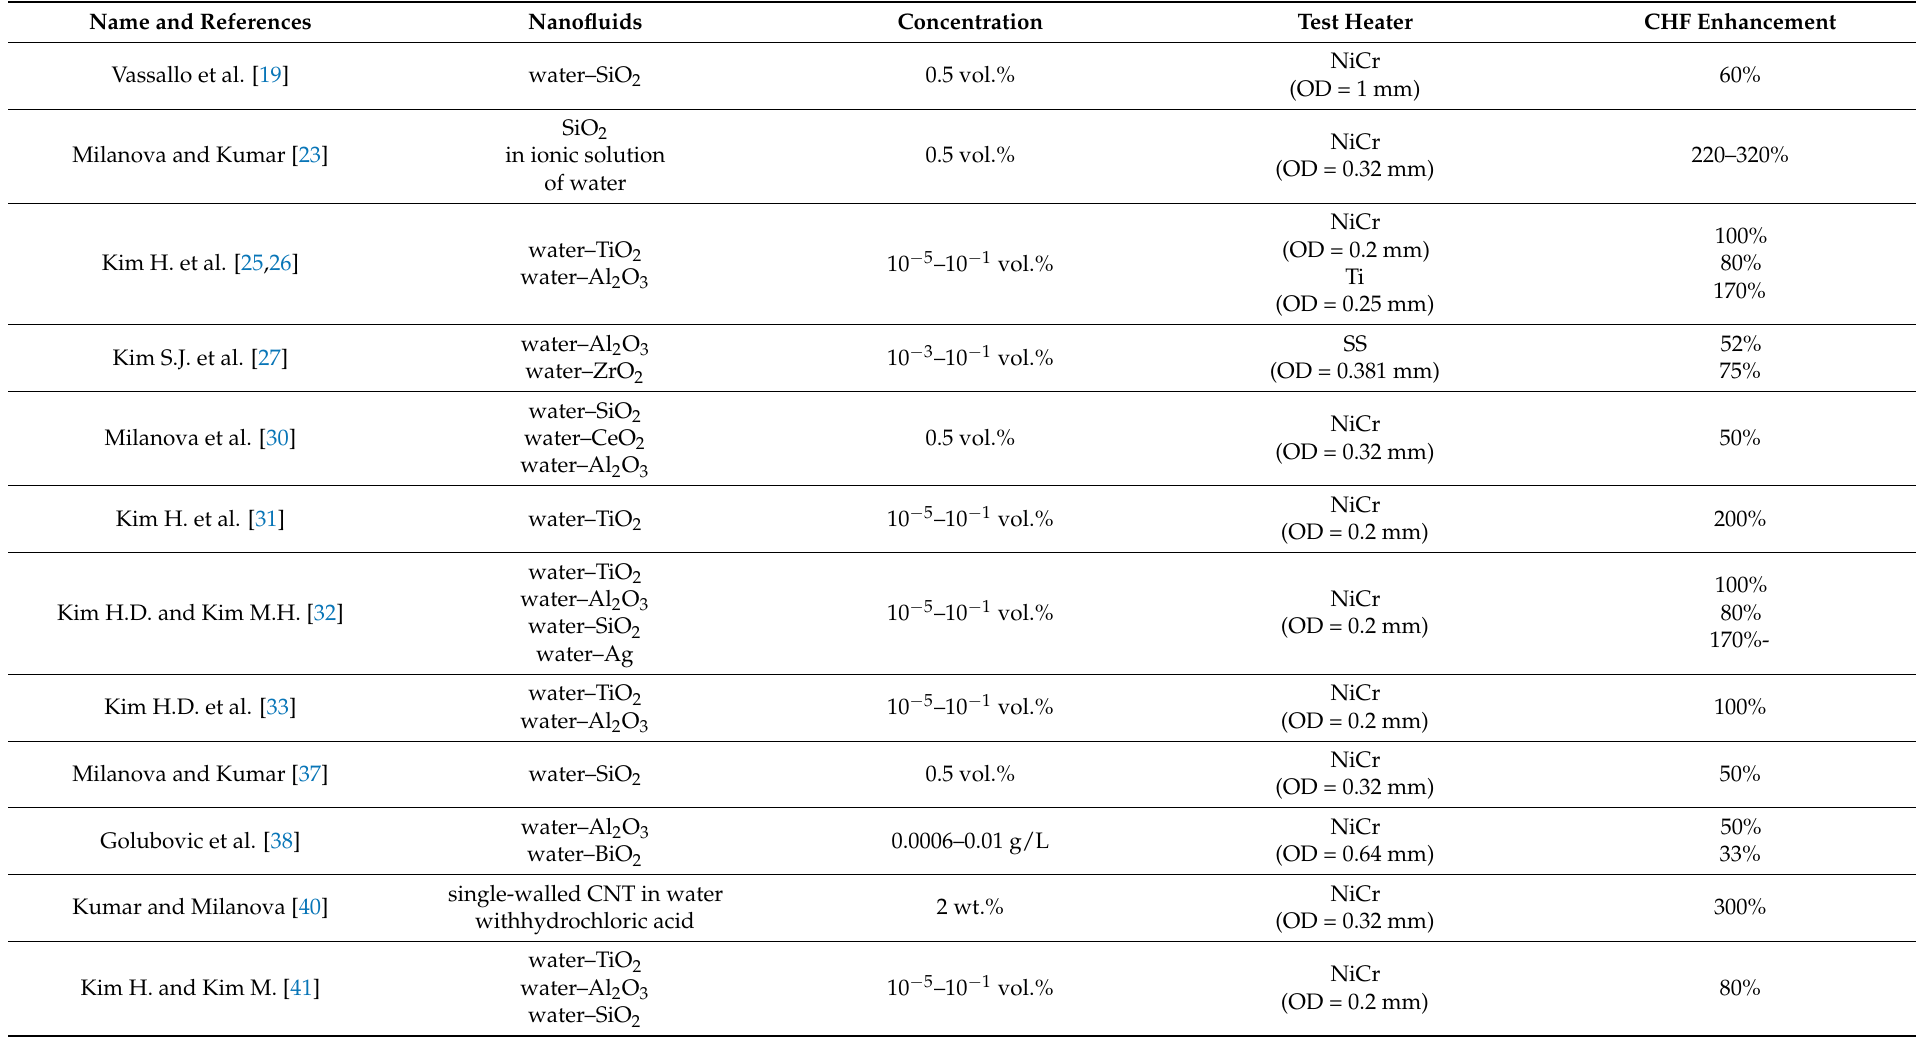
Table 1. Review of experimental studies on CHF of nanofluids in pool boiling on